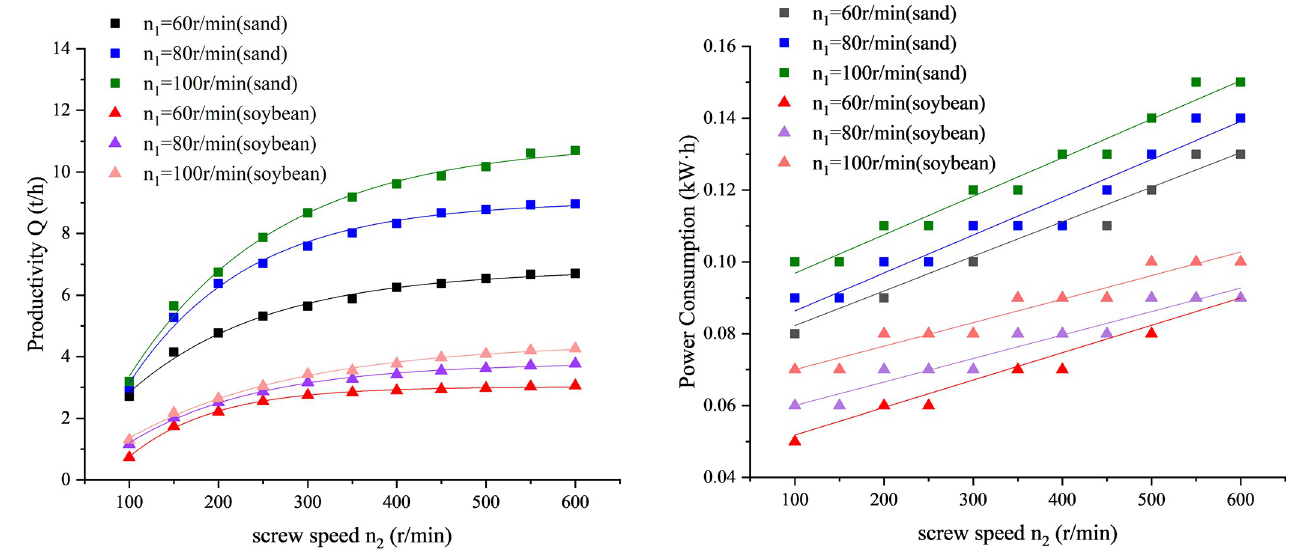
Fig 4. Curve of productivity and power consumption versus screw speed n 2 . (A) Productivity. (B) Power consumption.